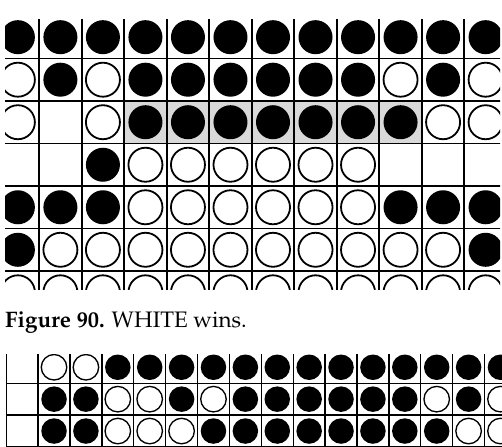
Figure 89. WHITE comes in.